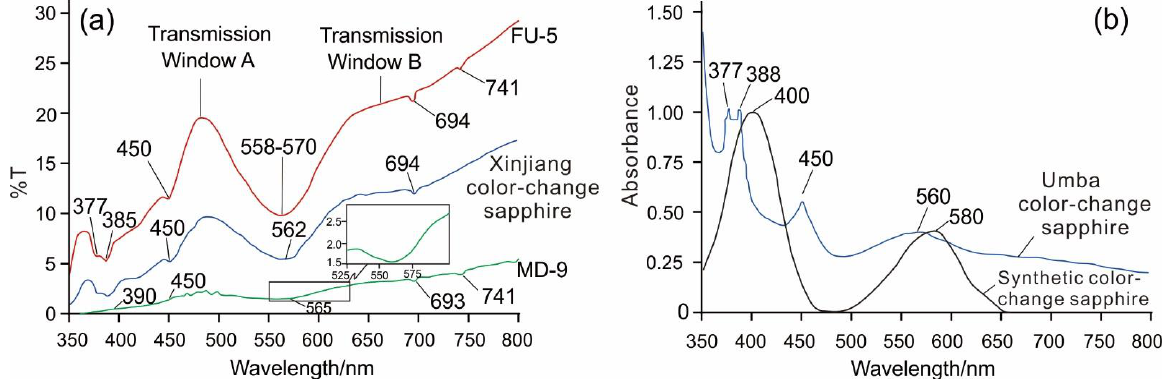
Figure 3. Ultraviolet and visible absorption spectra of color-change sapphires from different regions. ( a ) The absorption peaks at 377 nm, 385 nm, 450 nm, 694 nm and 741 nm and the absorption